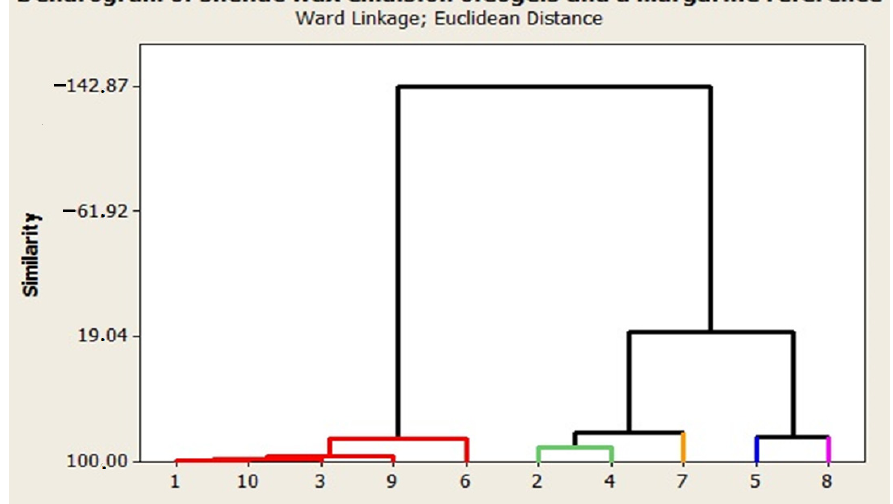
Figure 9. The dendrogram of shellac wax emulsion oleogels (1–9) and the margarine